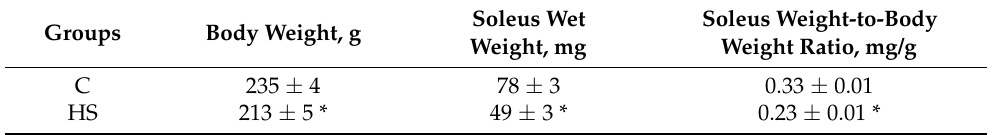
Table 2. Changes in body weight, soleus wet weight and soleus weight-to-body weight